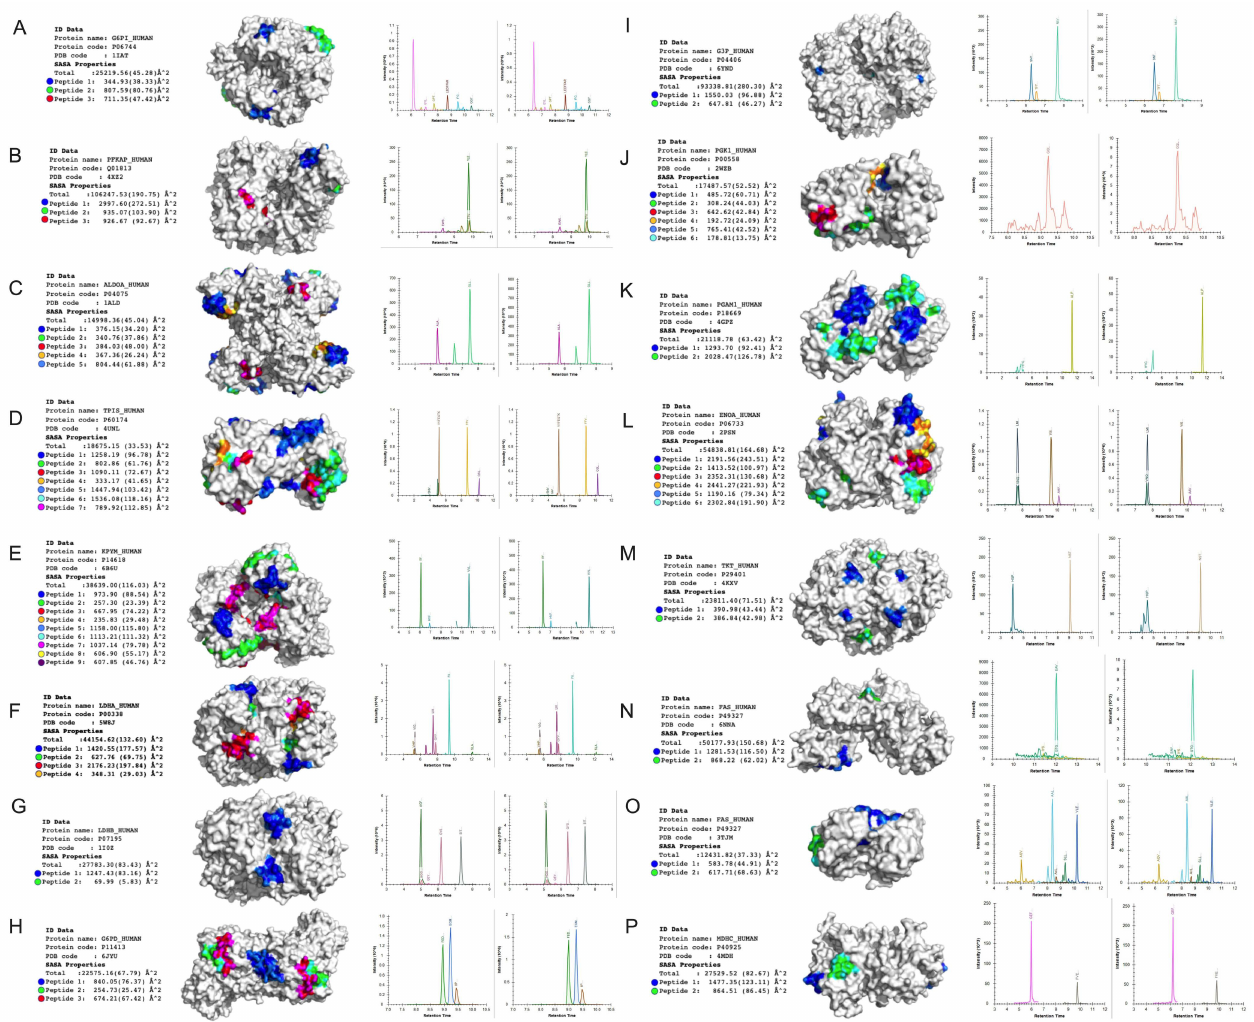
Figure 5. Peptides in the glycolytic enzyme structure. Left : The peptides are colored by the number for each glycolytic enzyme structure from the protein data bank (PDB) with the best resolution and coverture available. For each peptide, the solvent accessible surface (SASA) was calculated with the software freesasa, the average for residue is in parenthesis ( A – P ). The structures were prepared with pymol in surface mode and in biological assembly available from PDB (monomer, dimer, and tetramer). Right : MRM chromatogram of the transition used to trigger MS/MS for each protein associated with “glycolysis